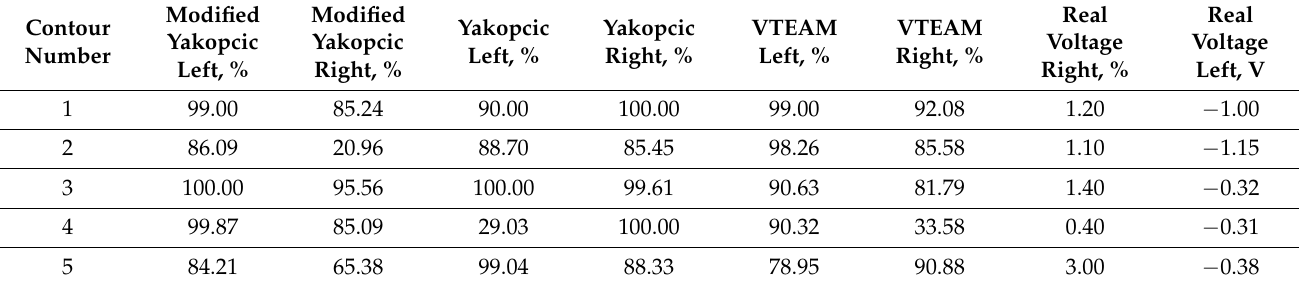
Table 3. The approximation accuracy of the threshold voltages in percent, and the values relative to which they were calcu- lated.